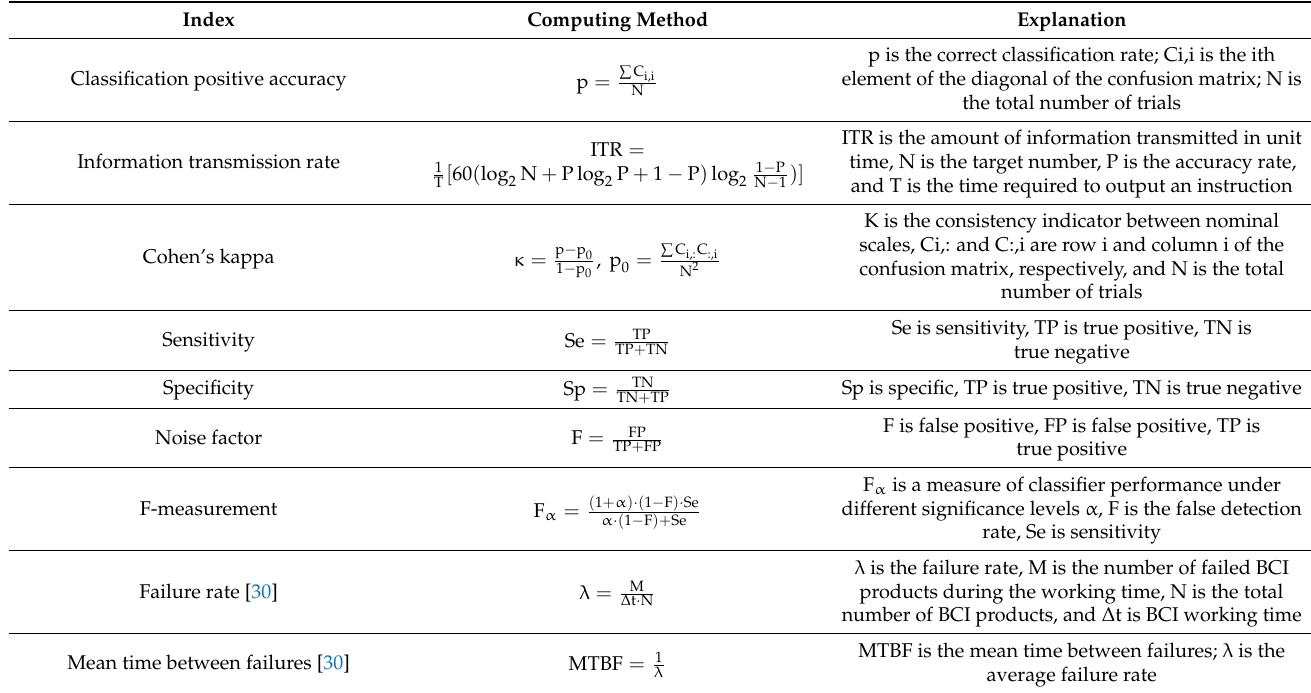
Table 2. Performance evaluation methods for general BCI